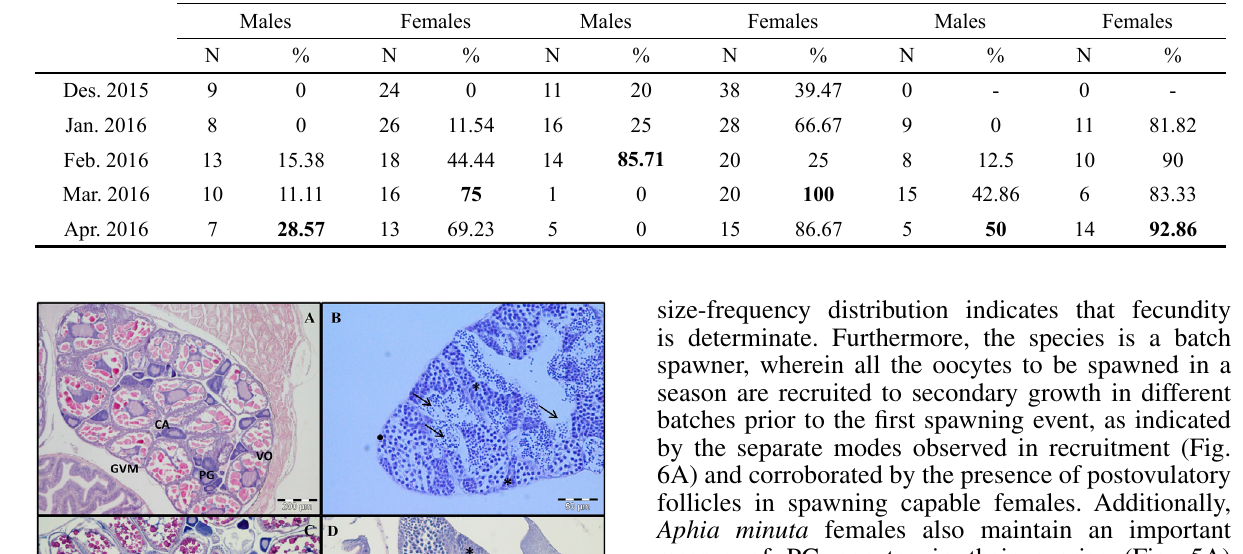
Table 5. Percentage of spawning capable specimens (%) with respect to the total number per month (N) by species and sex throughout the 2015-2016 fishing season. Aphia minuta